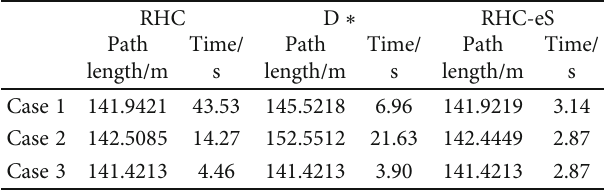
Table 3: Comparison of experimental results in simple environment.